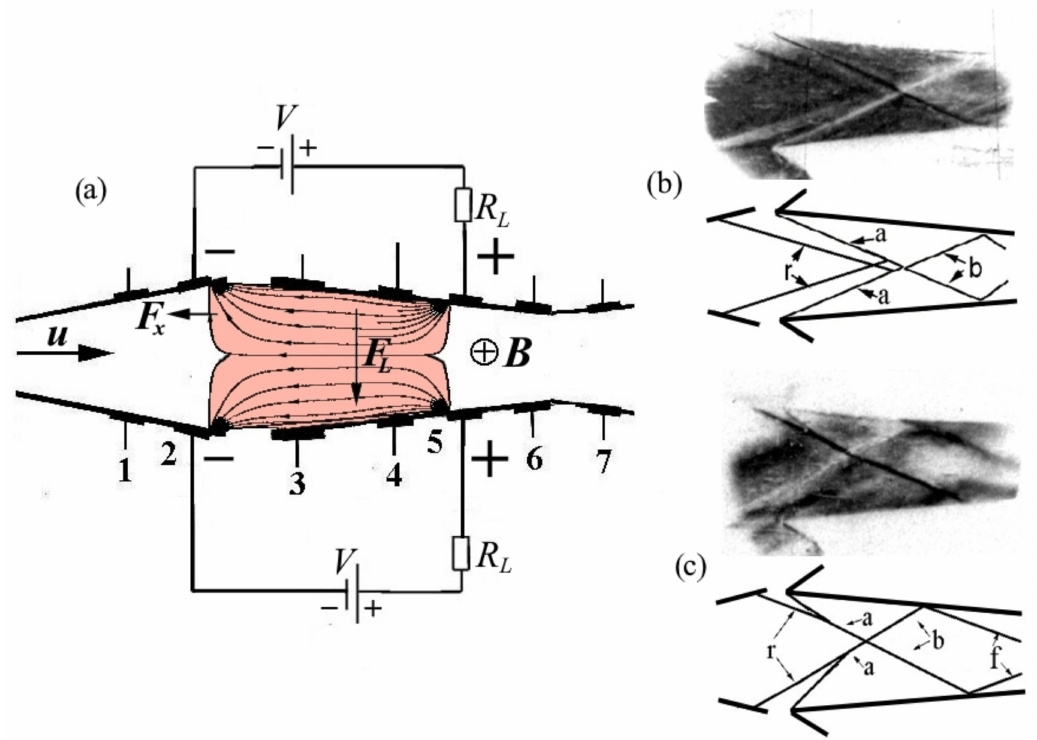
Figure 13. ( a ) Organization scheme of local longitudinal current in the entire volume of the diffuser; ( b ) Schlieren patterns of the flow and scheme of the attached shocks position : ( b ) I = 400 A, B = 0; ( c ) I = 400 A, B = 1.3